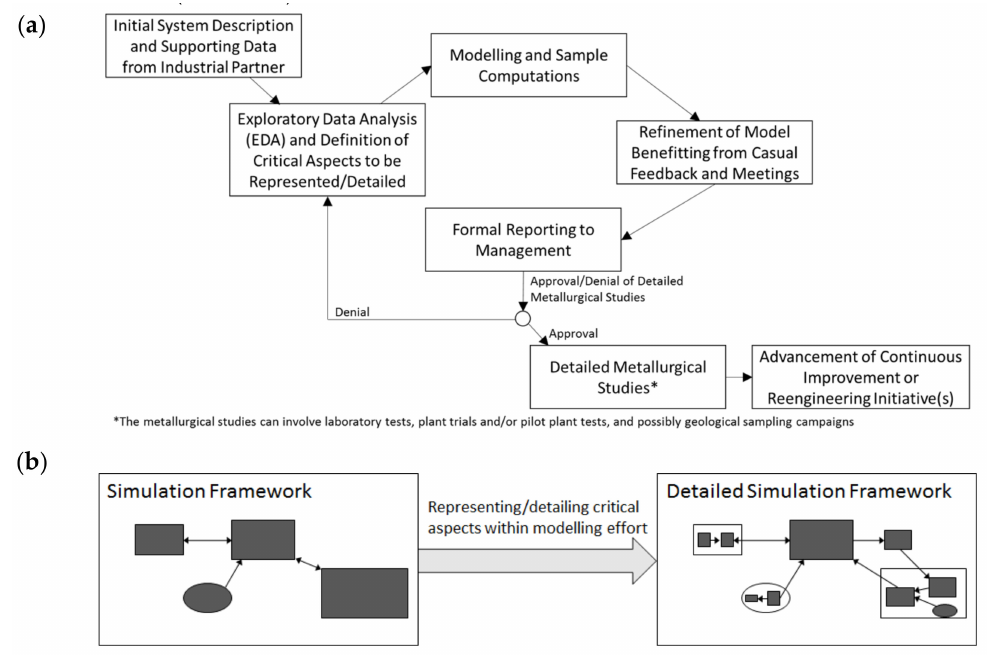
Figure 2. Development of extensible simulation framework prior to approval of metallurgical studies: ( a ) interaction with management leading to approval; ( b ) detailing of simulation framework through the incorporation of models and